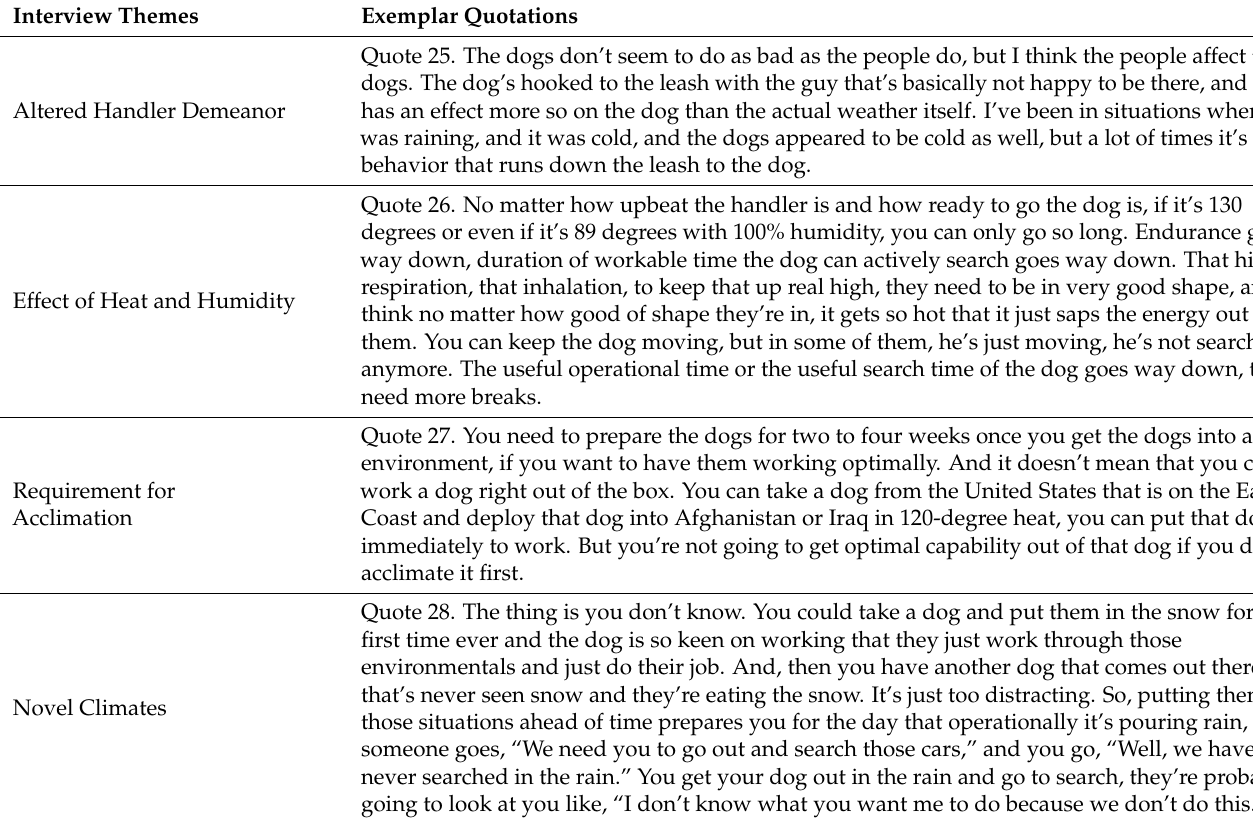
Table 6. Climate environmental factor themes and exemplar